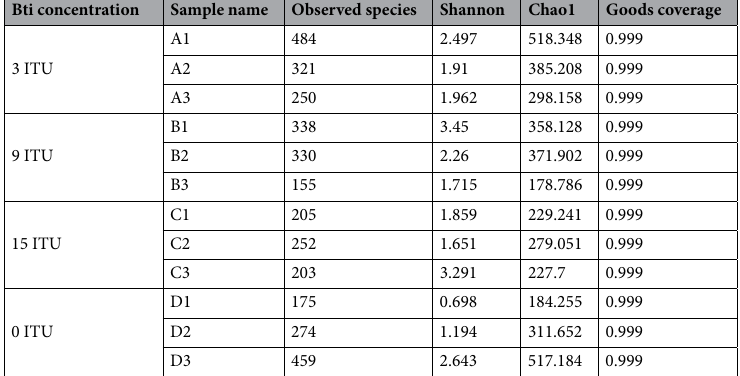
Table 1. Details of alpha diversity indexes of four groups.